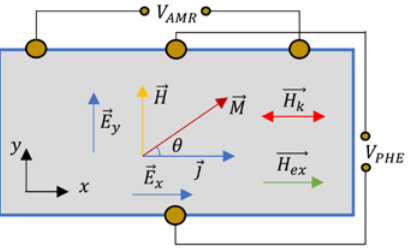
→ is the magnetization which makes an angle θ with M is the magnetization which makes an angle θ with the which is perpendicular on the applied current. → 𝑀𝑀��⃗ H which is perpendicular on the applied 𝐻𝐻��⃗